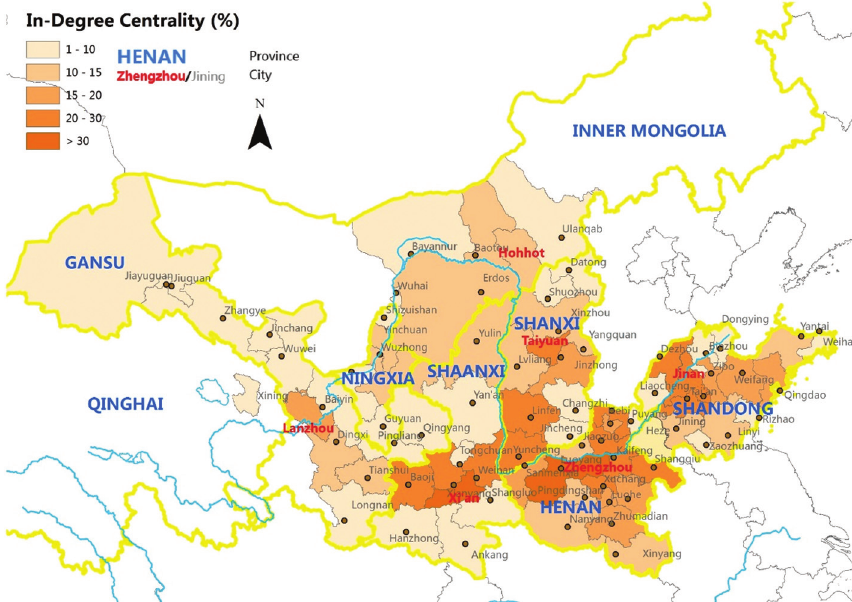
Figure 7: Distribution map of in-degree centrality of cities in the Yellow River